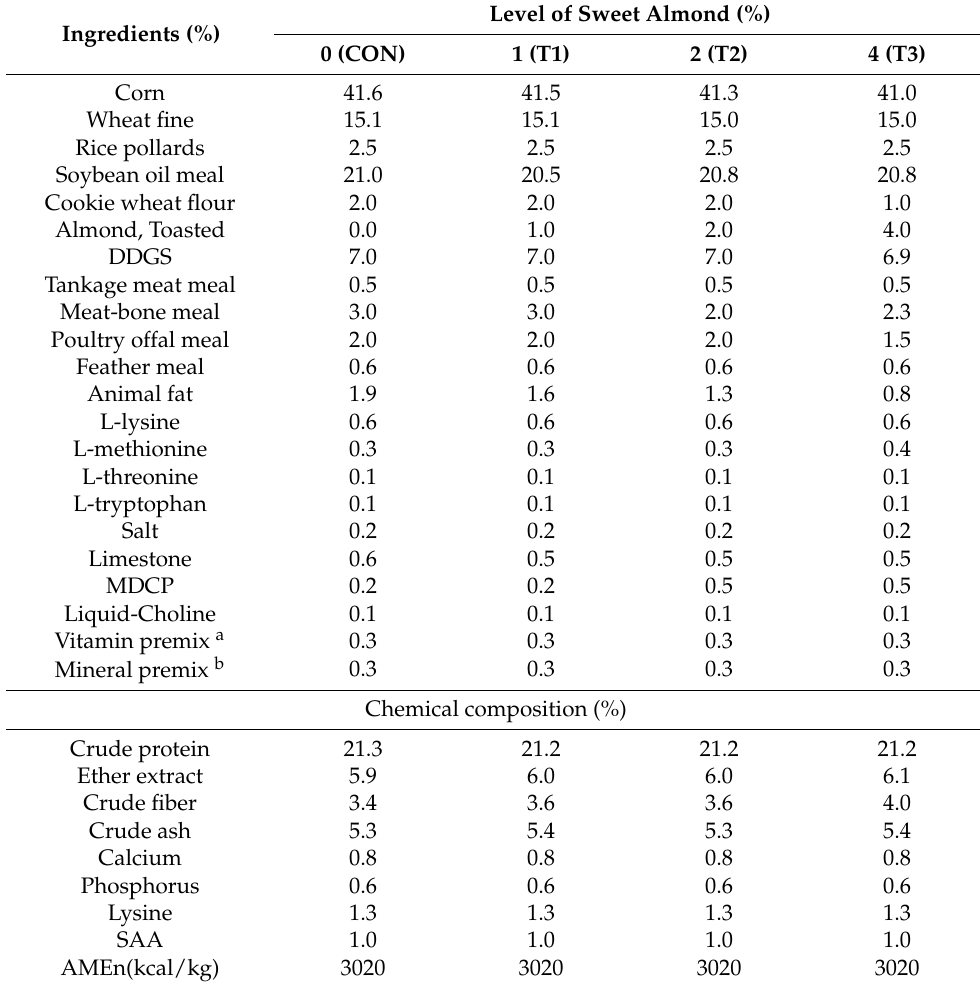
Table 3. Ingredient composition of experimental diets (phase 2/day